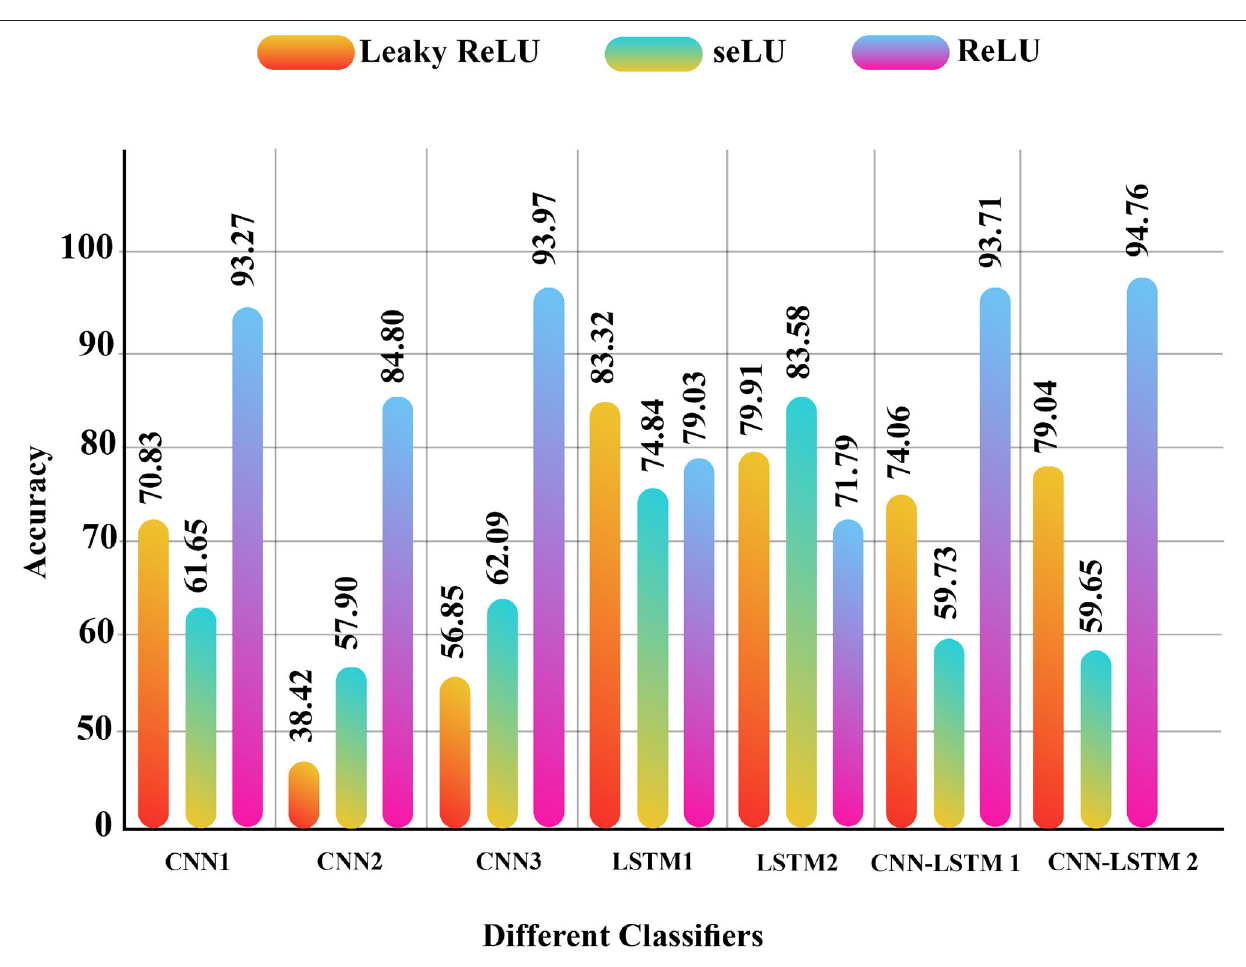
results of the DL algorithms with z -score + L2 normalization are presented. Also, the ROC curves for DL